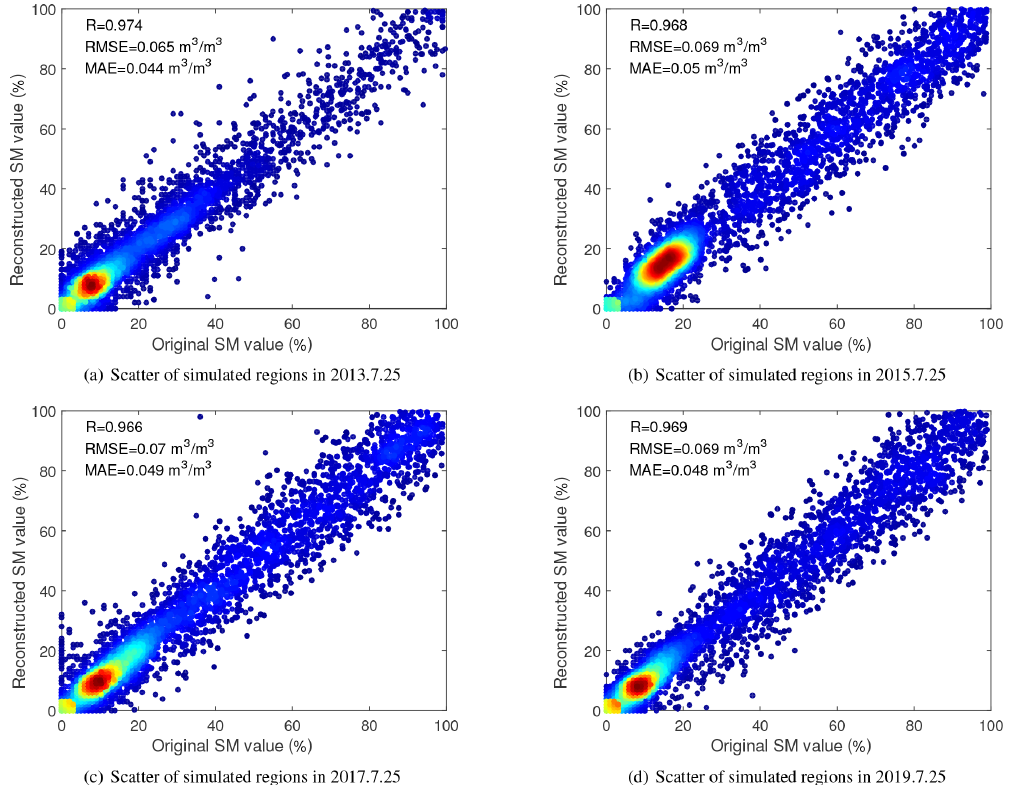
Figure 11. Original and reconstructed scatter of simulated regions in 2013, 2015, and 2017 and on 25 July